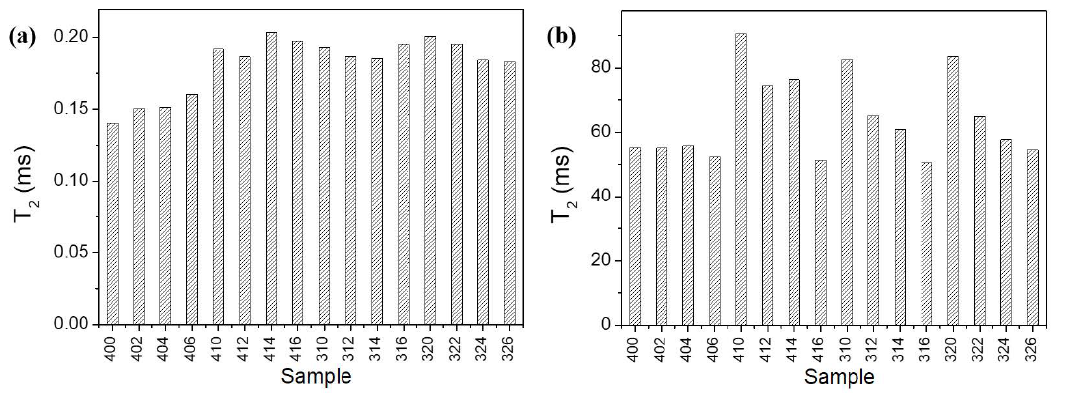
Figure 4. The position of the peak maximum in the case of intra-C-S-H water ( a ) and capillary cyclohexane ( b ).